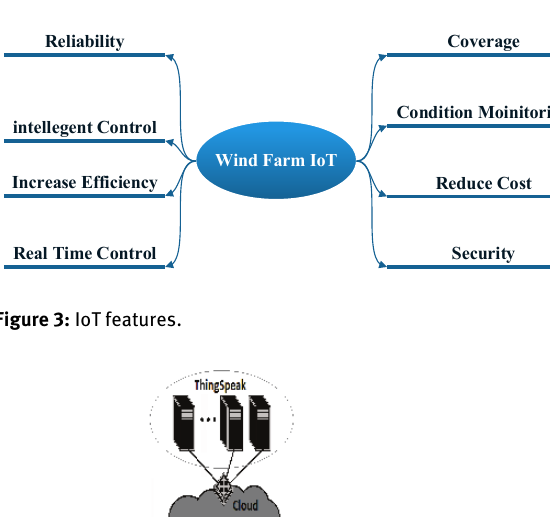
Figure 4. Each wind turbine in the wind farm is equipped with an IoT platform, as the Particle Electron, a cellular- connected microcontroller, that can be directly connected to a cellular network (the operator). The Particle Electron complies with any cellular standard [12]. Then, the wind data is saved and processed on the cloud using ThingS- peak [9]. the wind data can be accessed from any where in the world via, say a regular computer or a smart mobile phone, where commands can be directed to the wind